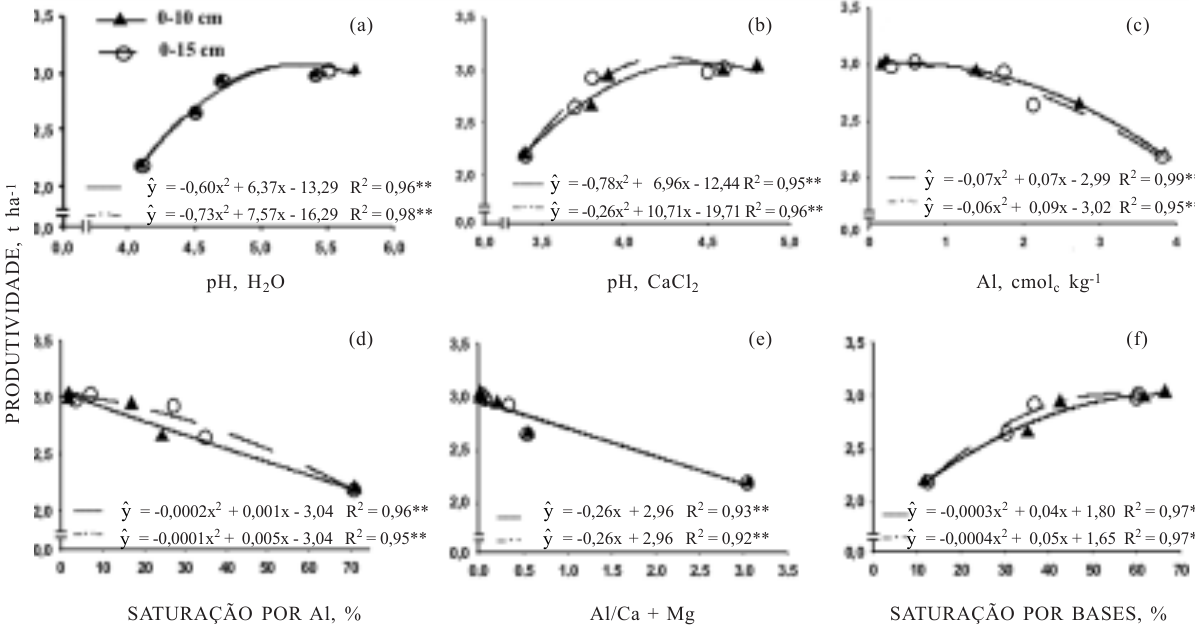
Figura 2. Relação entre a produtividade de grãos e o pH H Al (d), relação Al/Ca + Mg trocáveis (e) e saturação por bases (f) em duas camadas de um Latossolo Vermelho aluminoférrico típico cultivado por oito anos no sistema plantio direto, após a aplicação de calcário em área de campo